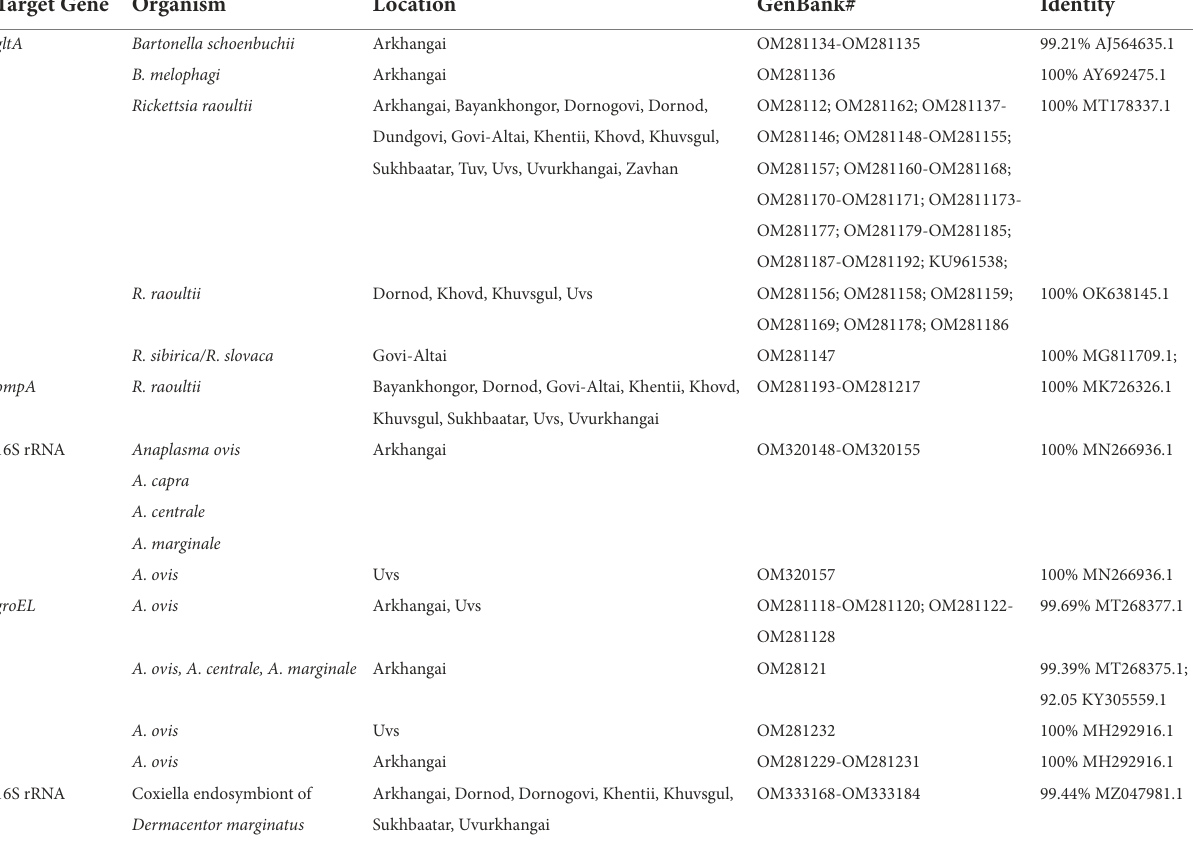
TABLE 6 Identity and Genbank accession numbers for Anaplasma, Bartonella and Rickettsia spp. from pooled samples Dermacentor spp. Target Gene